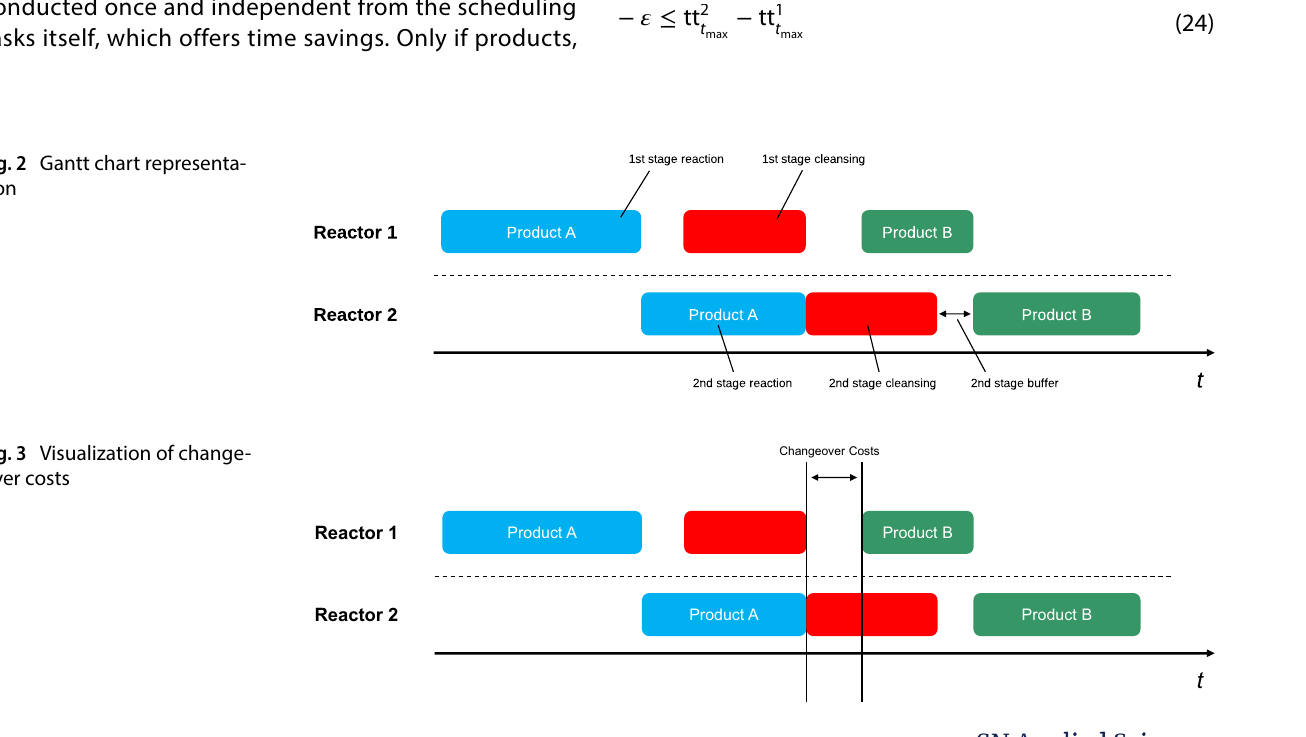
Fig. 2 Gantt chart representa- tion